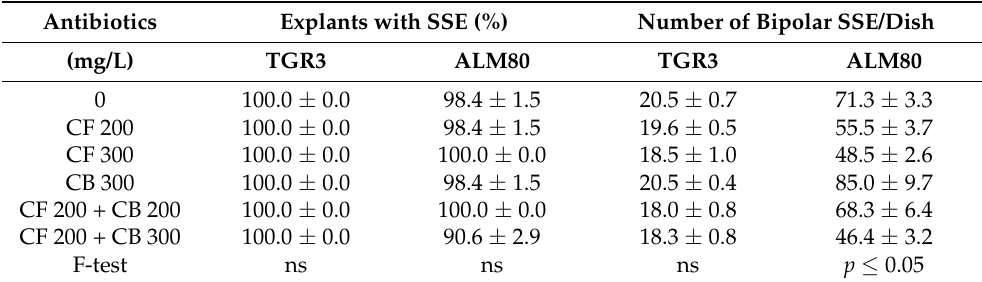
ns ns ns p ≤ 0.05 The values represent the mean ± standard error of eight replicates (eight explants each). SSE: secondary somatic embryos; CF: cefotaxime; CB: carbenicillin. The data were analyzed by one-way ANOVA. ns, not significant.